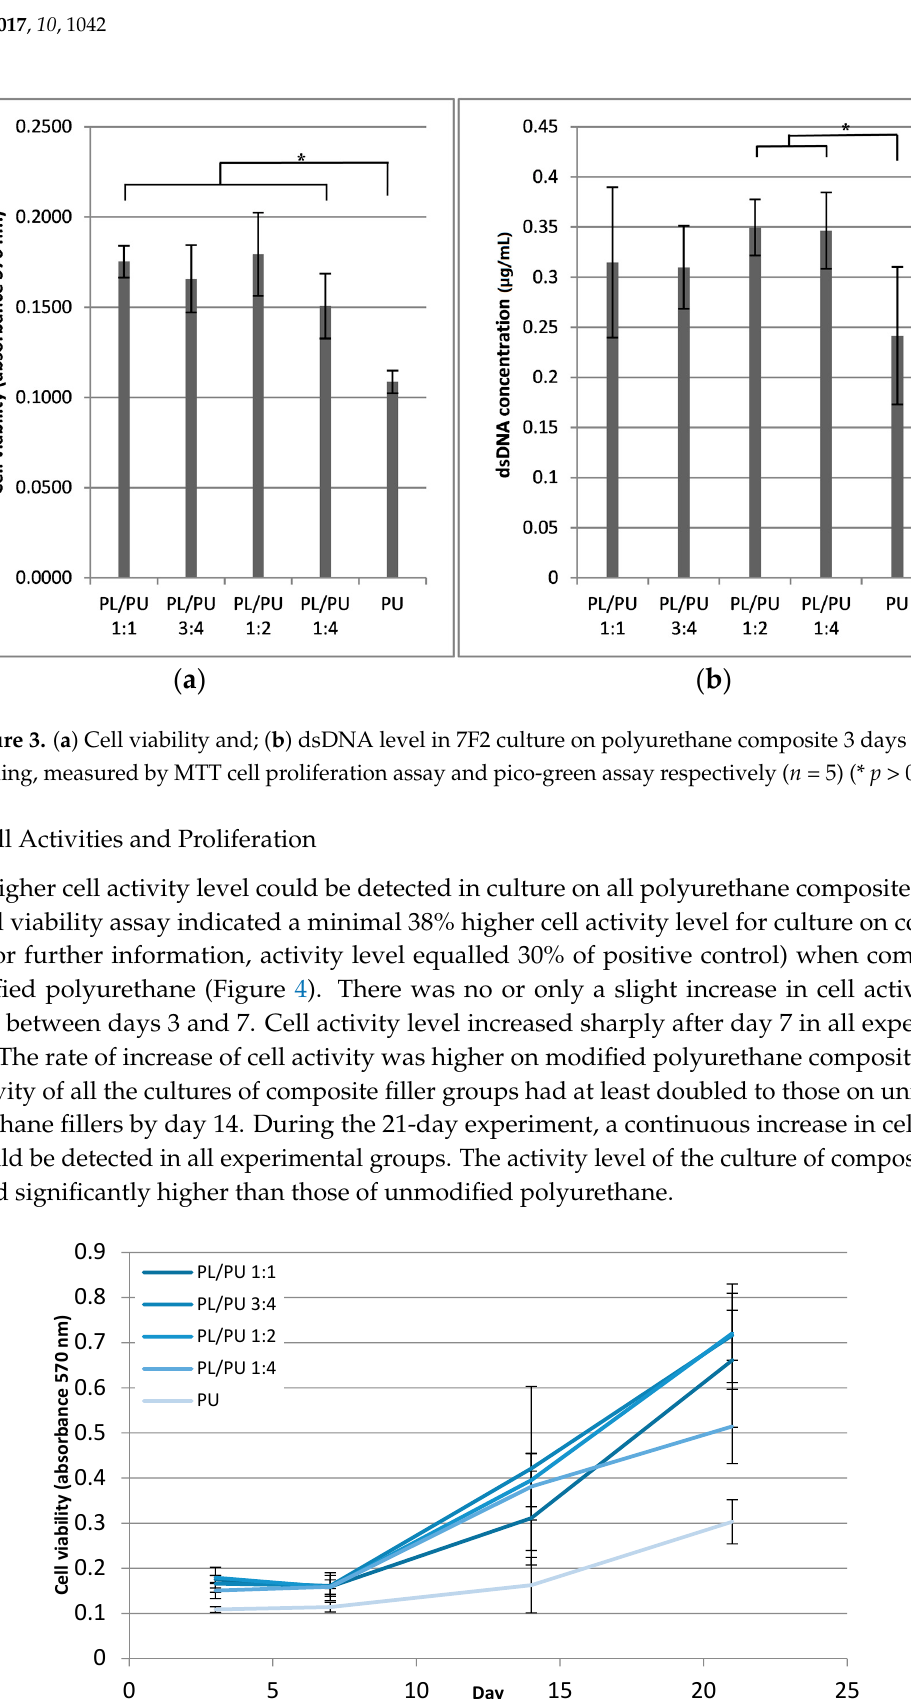
Figure 4. Cell viability level throughout a 21-day culture period of 7F2 cells on polyurethane composites, measured with MTT cell proliferation assay ( n = 5).